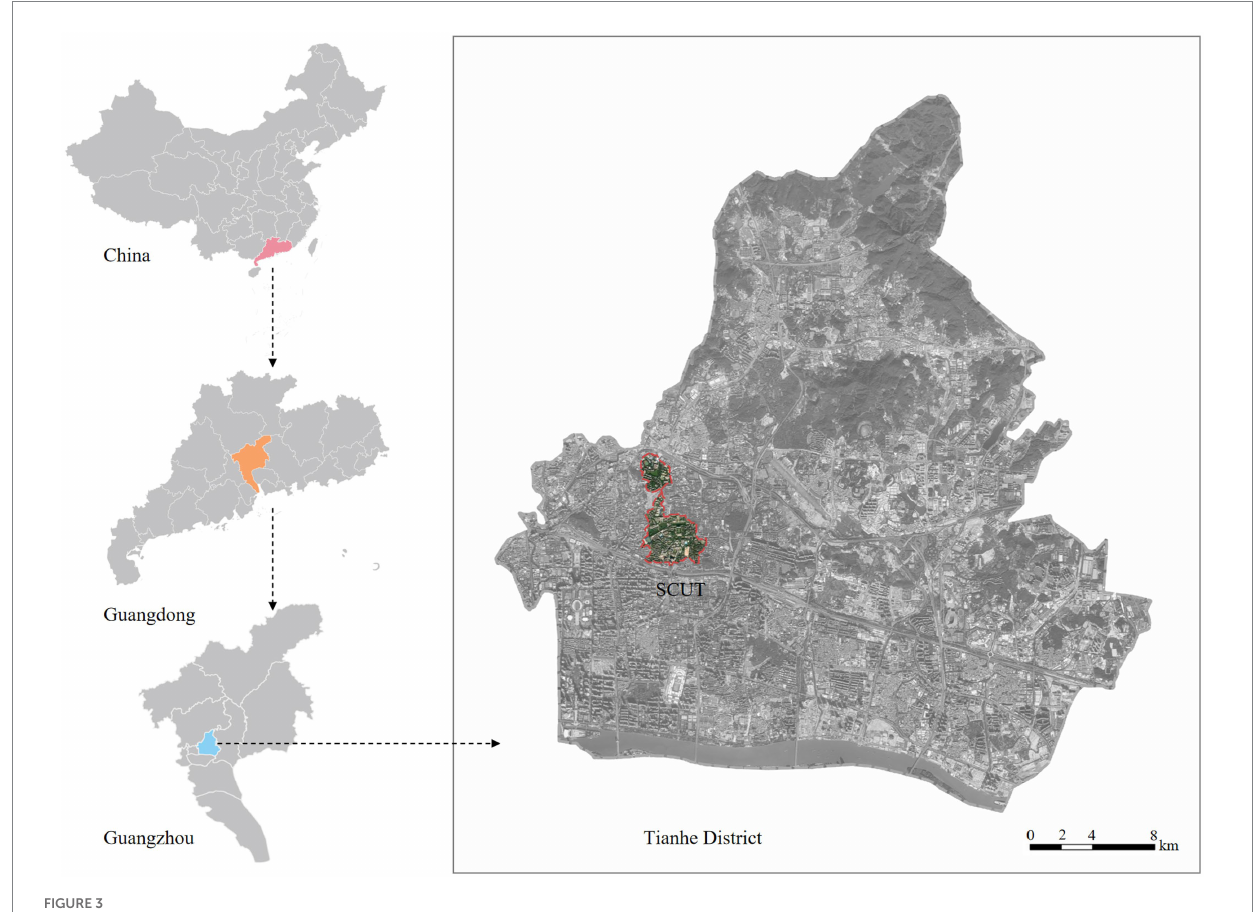
FIGURE 3 Location map of SCUT Wushan